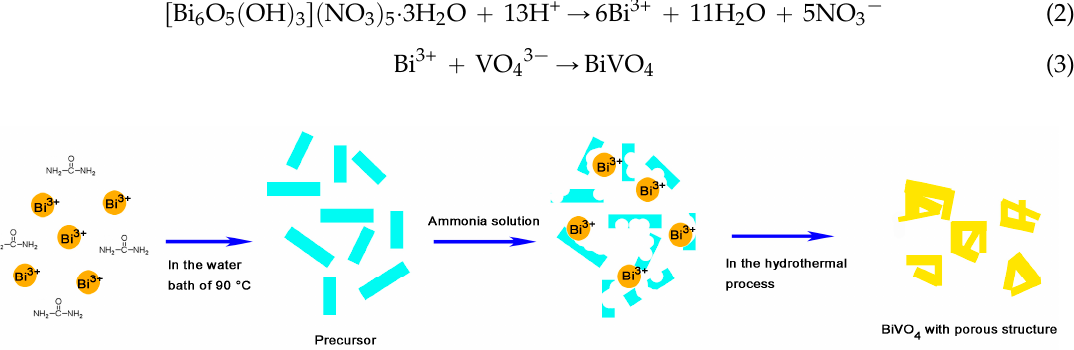
Scheme 1. Schematic illustration for the possible formation mechanism of BiVO 4 with porous structure.